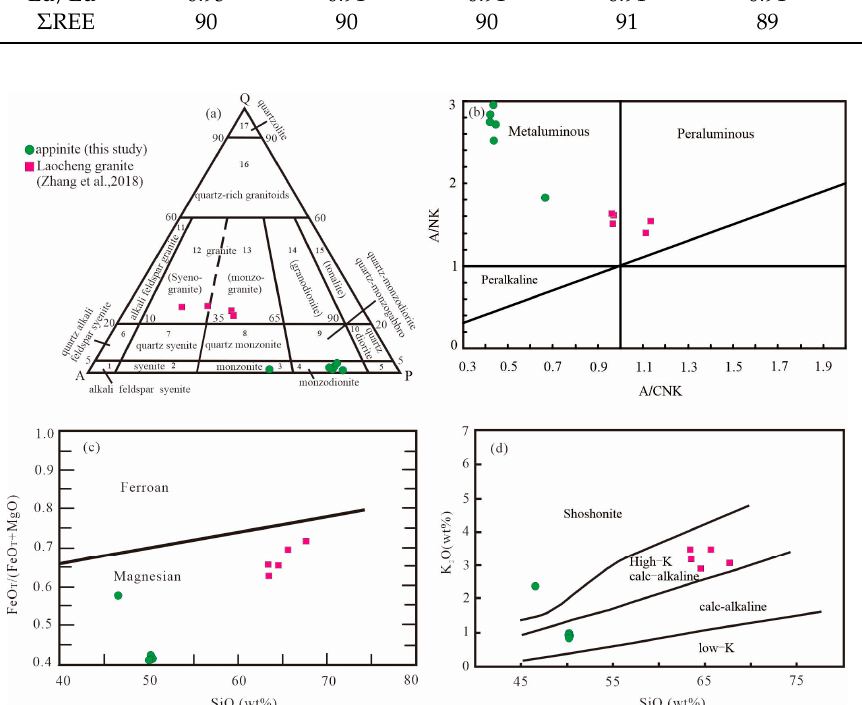
Figure 6. Plots of Q-A-P ( a ), A/NK [Al 2 O 3 /(Na 2 O + K 2 O)] vs. A/CNK (molar ratio Al 2 O 3 /(CaO + Na 2 O + K 2 O)); ( b ), SiO 2 -FeO/(FeO + Mg) ( c ) and SiO 2 -K 2 O ( d ) diagrams for the Triassic Laocheng